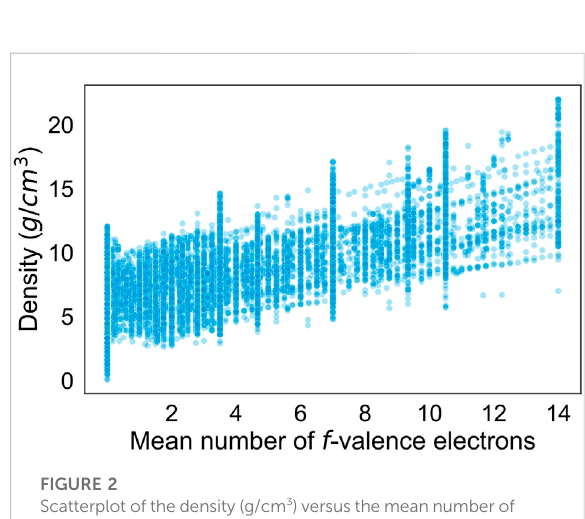
FIGURE 2 Scatterplot of the density (g/cm 3 )versus the mean number of f-valence electrons in